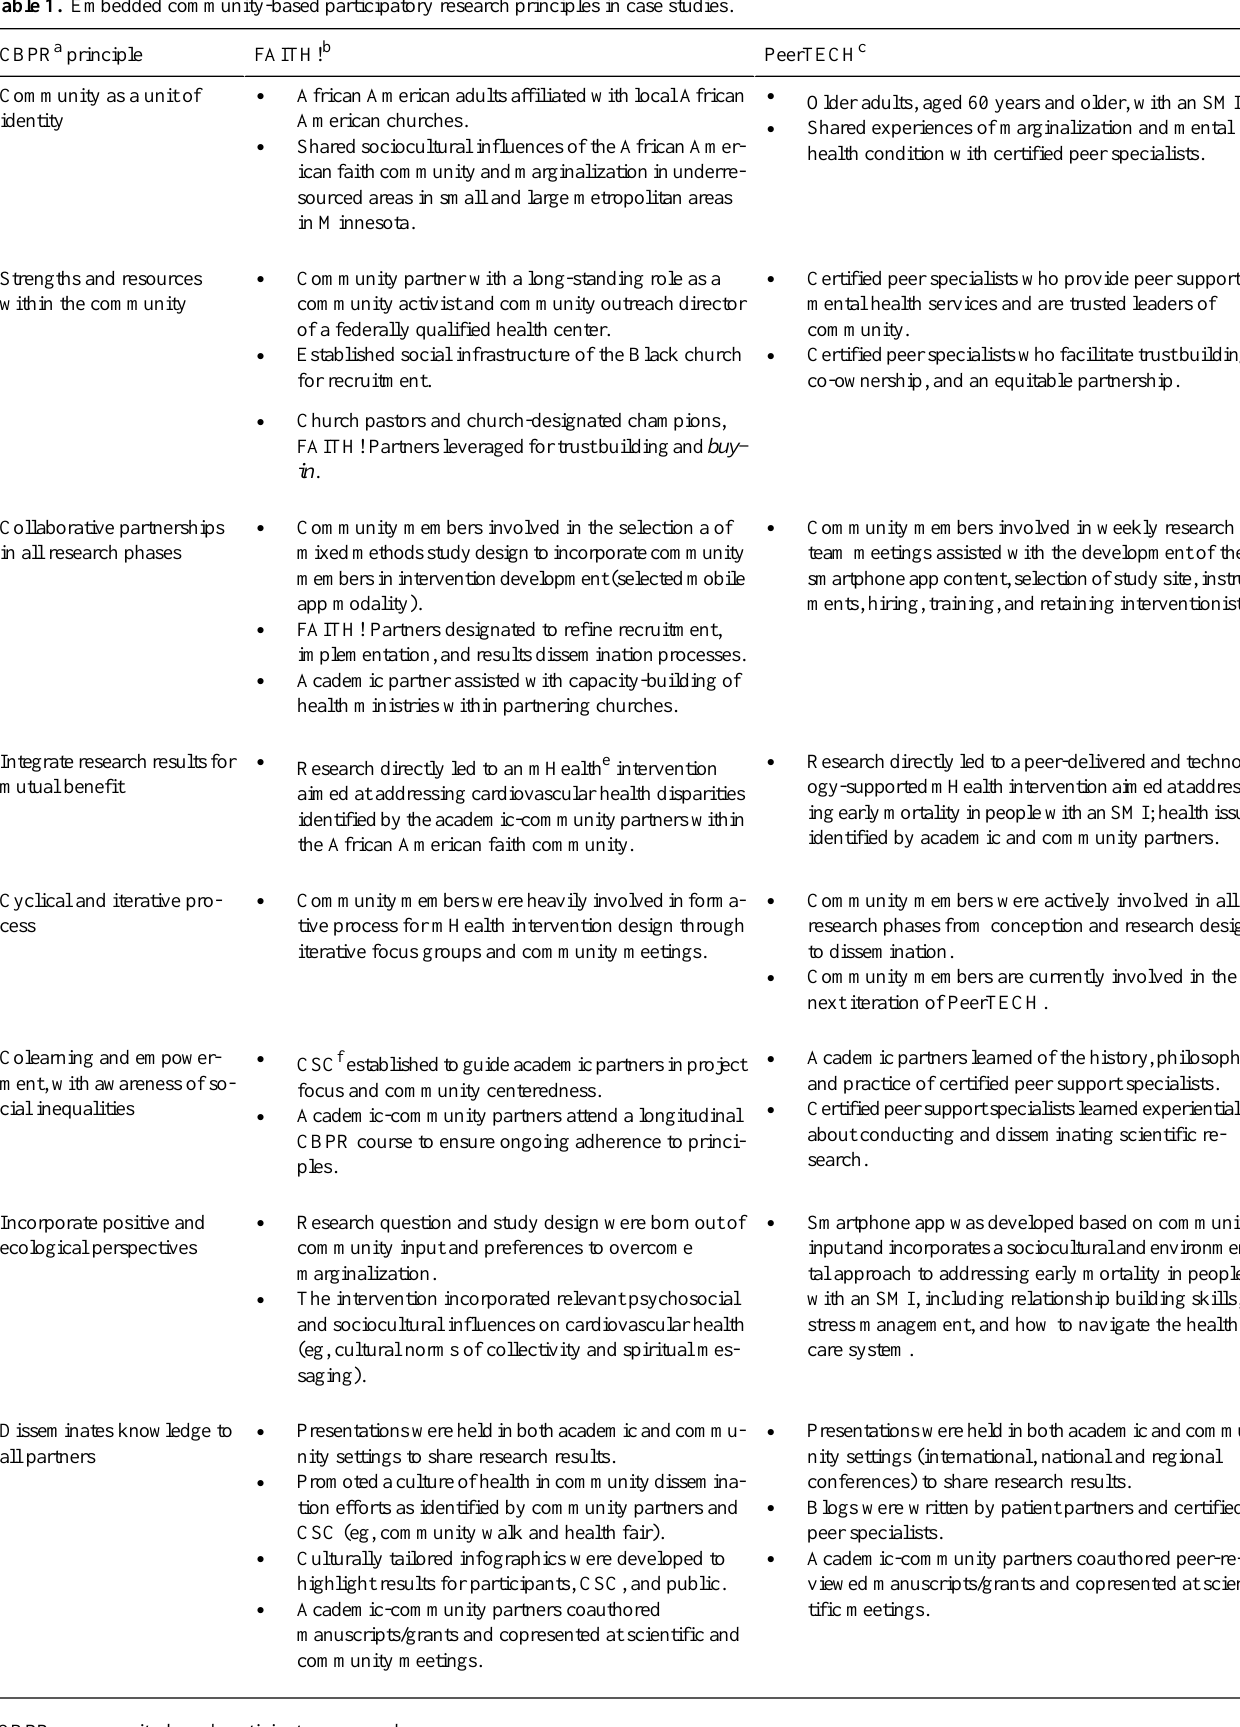
Table 1. Embedded community-based participatory research principles in case